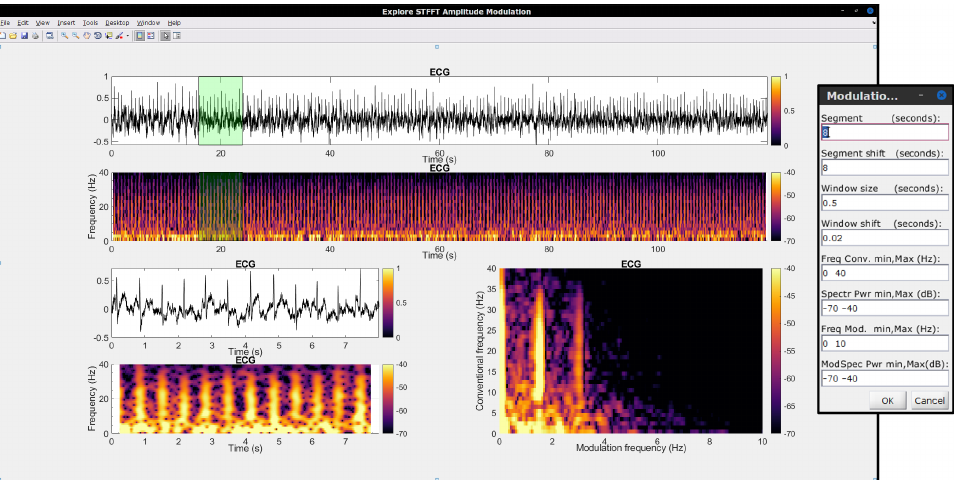
Figure 9. A screenshot of the in-house developed open-source. Amplitude Modulation Analysis (AMA) Toolbox user interface. The toolbox can be used for modulation spectral signal